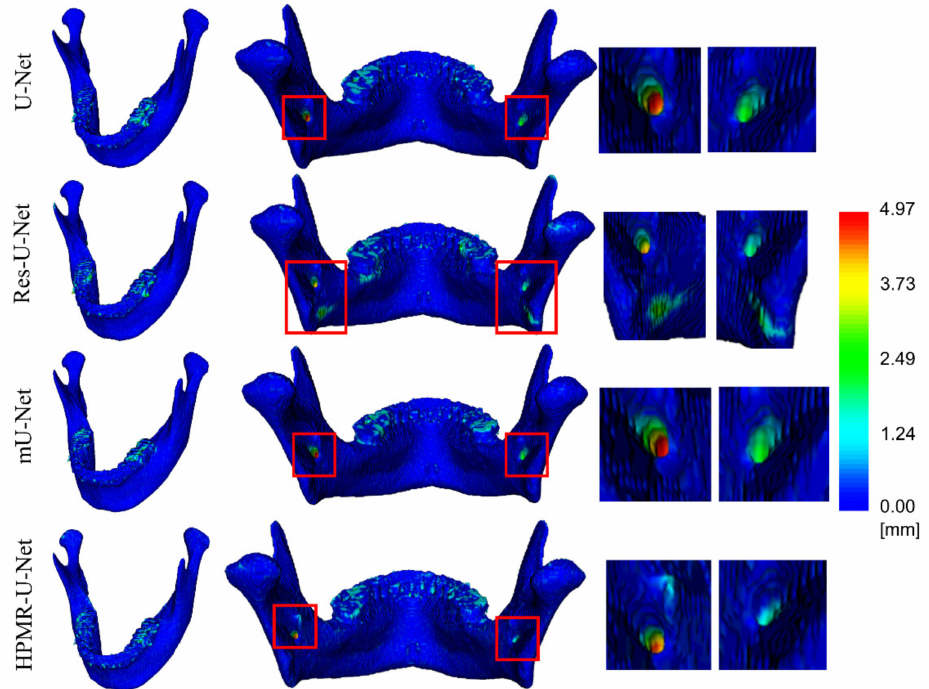
Figure 9. Color maps of surface distance from the ground truths to the output segmentations of the best dice coefficient case in the CenterA dataset for the mandible. The pieces of images on the right side are enlargement of mandibular